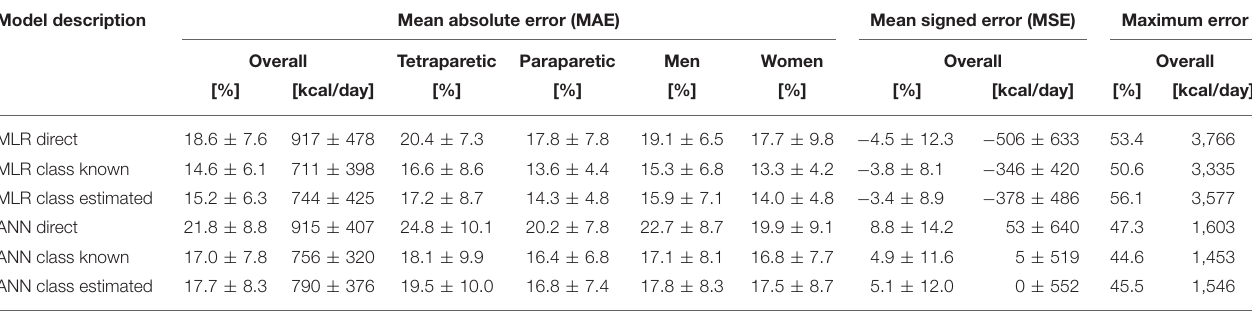
TABLE 4 | Evaluation of the different EE estimation models developed within this study, which were either based on a multi-linear regression (MLR) or based on artificial neural network (ANN). Model description